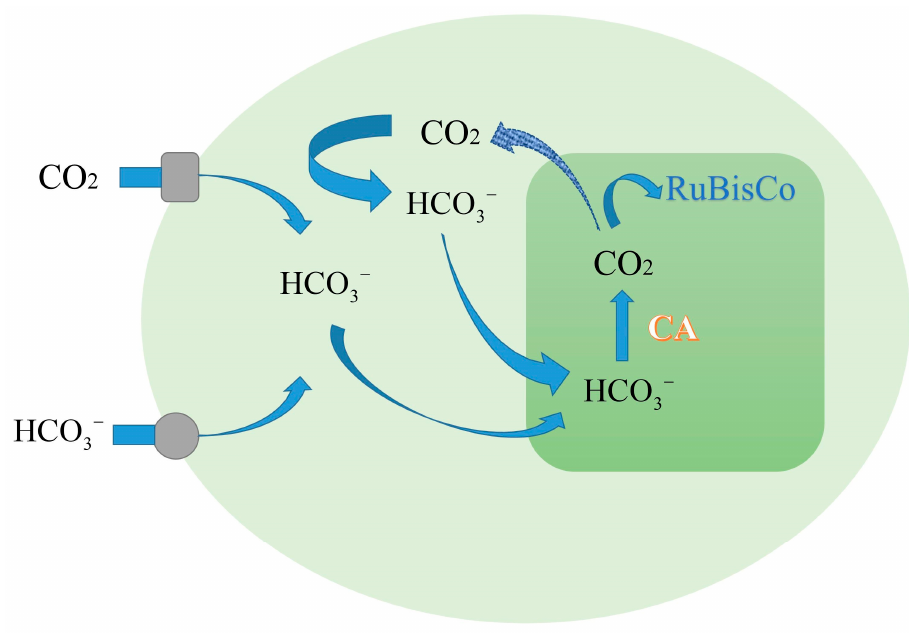
Figure 3. The simplified model of CCM.